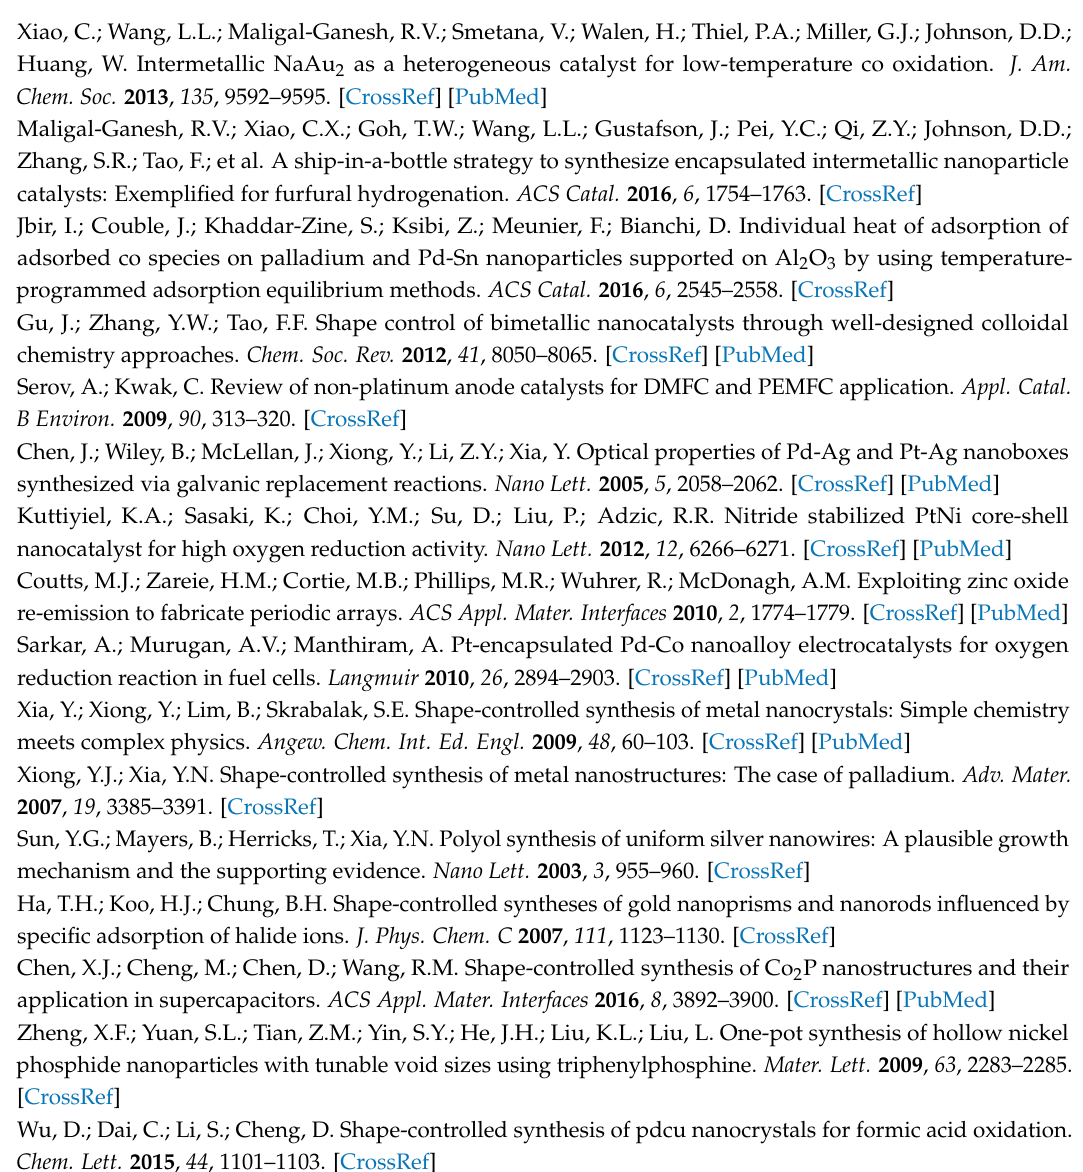
Figure S1: STEM-EDS elemental maps of the NPFNP-1, Figure S2: STEM-EDS elemental maps of the Pd-Fe 3 O 4 , Table S1: Suzuki-Miyaura coupling reactions of 4-bromo anisole with phenylboronic acid catalyzed by